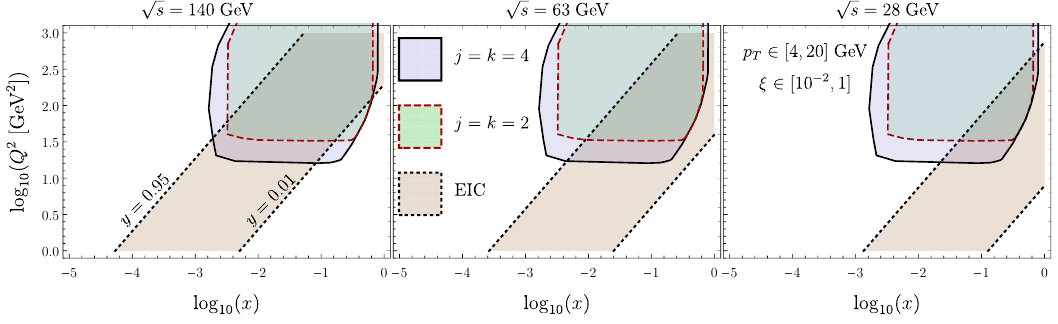
Figure 2 . The jet-rapidity regions for which ^ s ( j = 2) and Q p T : red-dotted k = 4 and magenta-dotdashed ( k = 2). The overlapping region (cid:24) which is found at central rapidities is where we anticipated small contributions to the cross section beyond factorization.